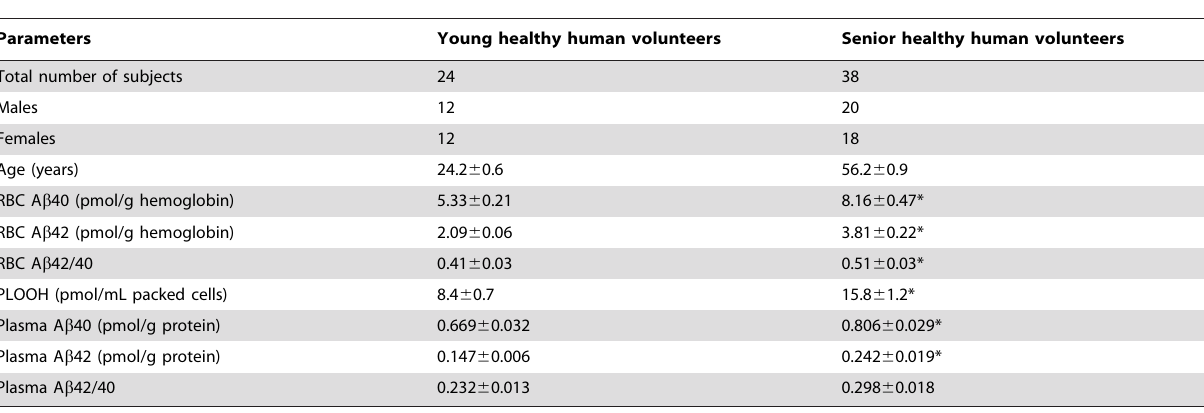
Table 1. Amyloid b levels in RBC and plasma of young healthy human volunteers and senior subjects.